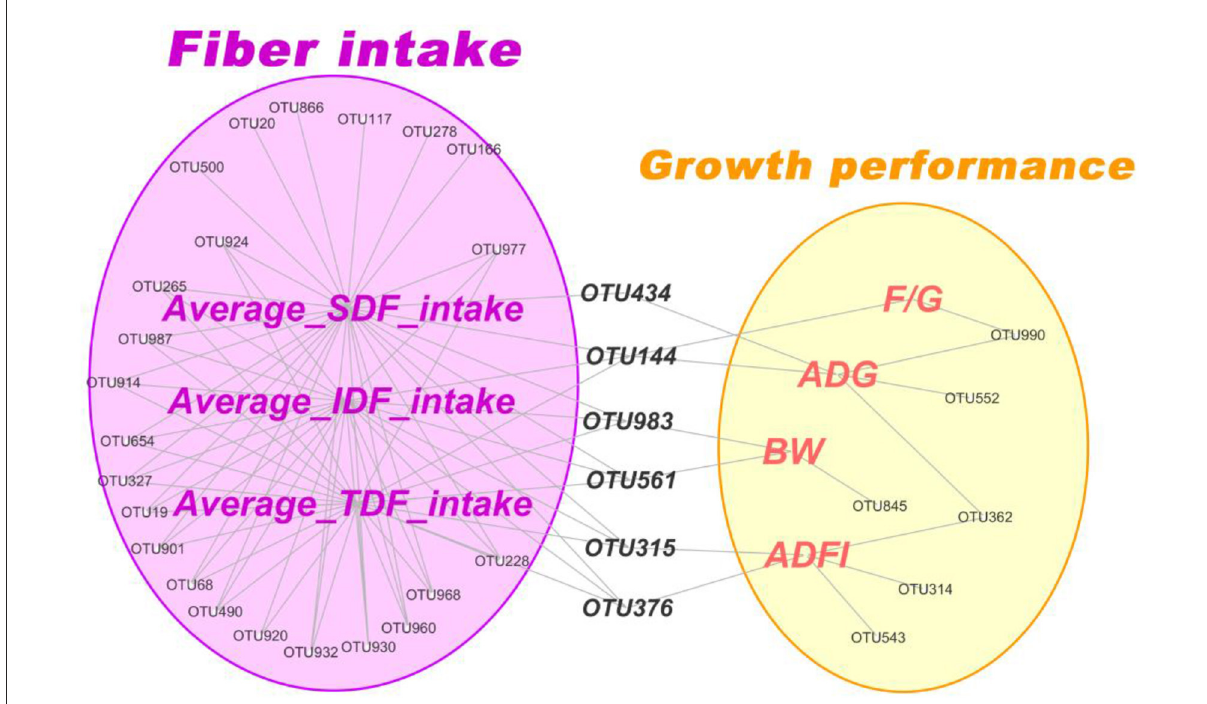
FIGURE9 Correlation network analysis between dietary fiber intake and growth performance of pigs with dominate microbiota (top 100 OTUs) in feces. Only OTUs significantly related to these indicators ( P < 0.05) were shown in